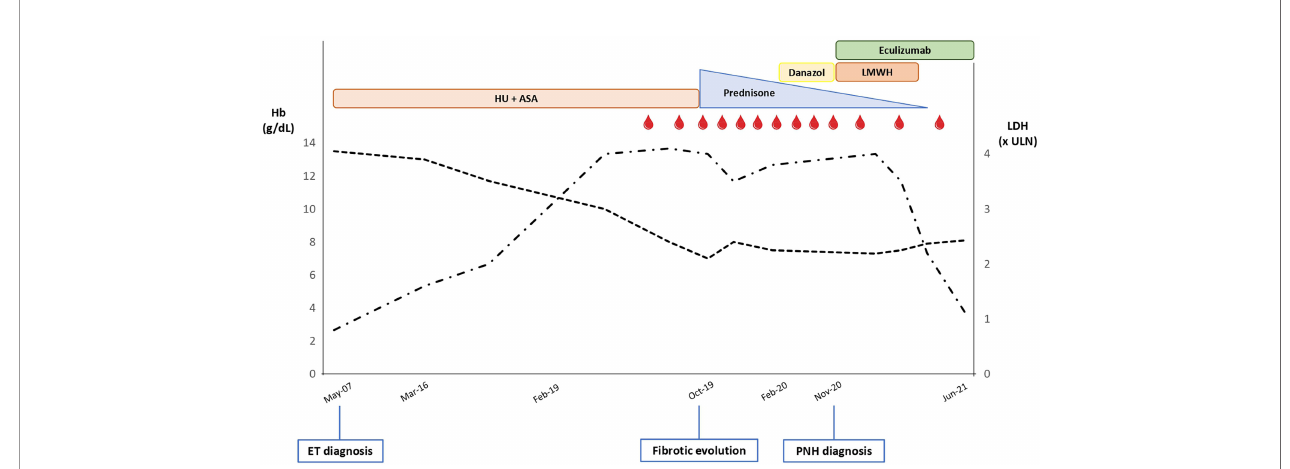
FIGURE 1 | Trend of hemoglobin (Hb; dotted black line) and lactate dehydrogenase (LDH; dashed-dotted black line) levels along the patient ’ s clinical journey. ULN, upper limit of normal; HU, hydroxyurea; ASA, acetylsalicylic acid; LMWH, low-molecular weight heparin; ET, essential thrombocythemia; PNH, paroxysmal nocturnal hemoglobinuria. Red drops represent red blood cell